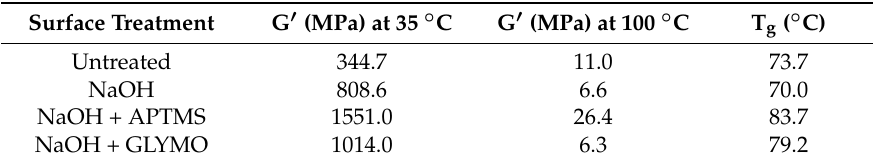
Figure 8. Plot evolution of the ( a ) storage modulus (G (cid:48) ) and ( b ) damping factor (tan δ ) in function of temperature for fibreboards with PO subjected to different surface treatments. Table 1. Storage modulus (G (cid:48) ) values at different temperatures and glass transition temperatures (T g ) for fibreboards with PO subjected to different surface